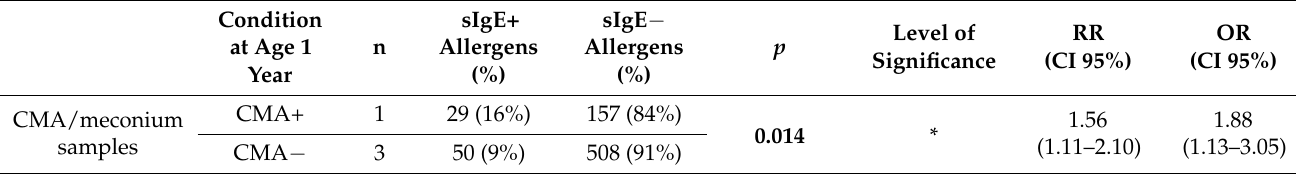
Table 1. The prevalence of sIgE responses in neonatal fecal samples is predictive of doctor-diagnosed IgE-mediated conditions at the age of 1 year. The presence (sIgE+) or absence (sIgE − ) of sIgE to each allergen among the 186 allergens yielding at least one positive response in the study population (3162 sIgE data, i.e., 21 samples × 186 allergens) was analyzed for each condition. The meconial samples, which were associated with one case of CMA but no asthma or AD, were analyzed separately from the later samples. The analysis was performed using Fisher’s exact test. AD, atopic dermatitis; CMA, cow’s milk allergy; OR, odds ratio; RR, relative risk. Asterisks indicate significant differences (* p < 0.05; **** p <